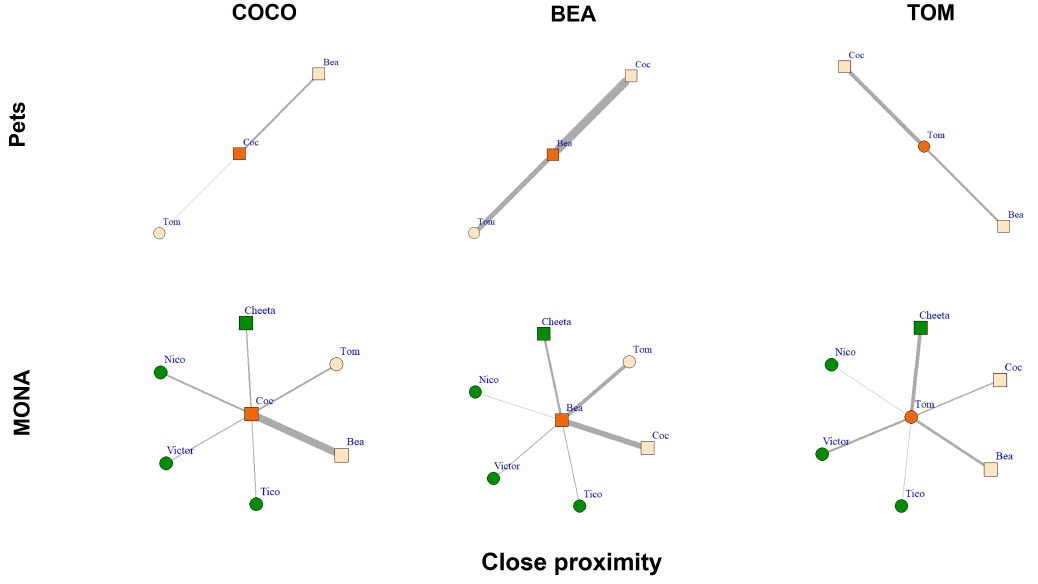
Figure 8. Close proximity networks of Coco, Bea and Tom while housed as pets (upper row) and at MONA (bottom row). Edges represent percent of scans spent within close proximity (i.e., within an arm’s reach); circles represent males, squares represent females. Vertex colour: orange = focal individual; peach coloured = familiar individuals; green = new conspecifics at MONA. Overall, we show that all three chimpanzees increased their close proximity net- works by spending time within an arm’s reach of all other group members at MONA. This finding, together with the results of negligibly low or no occurrence of agonistic interac- tions provides an indication of the optimal appropriate group composition at MONA.